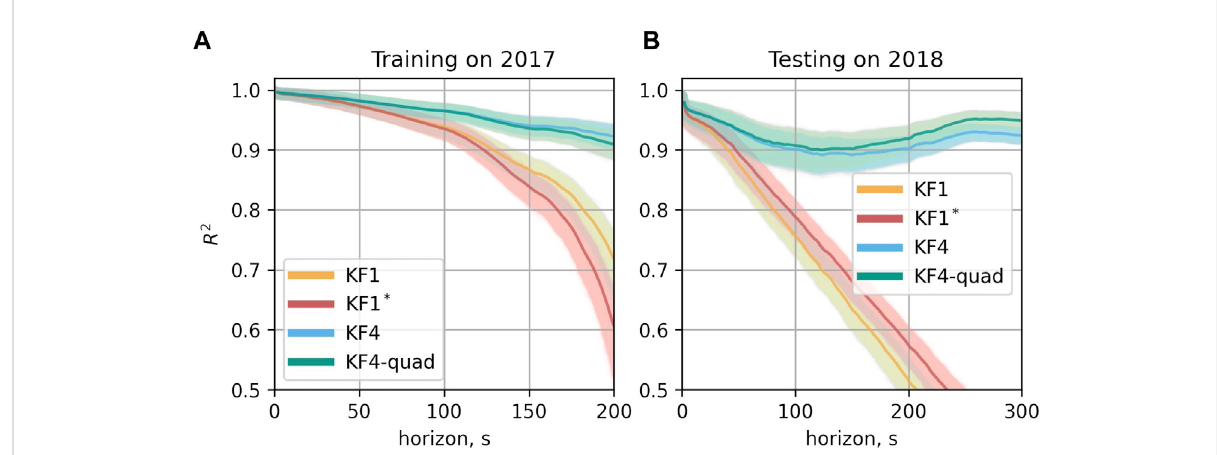
FIGURE 8 R 2 -scoreasafunctionoftheforecasthorizon. (A) Onthetrainingdataset,herefrom2017 (B) onthetestdatafrom2018.Themeanvalueof R 2 is shown for each horizon in the darker color. The mean value was computed from 1,000 bootstrapped estimates of R 2 , which are shown in the light color.